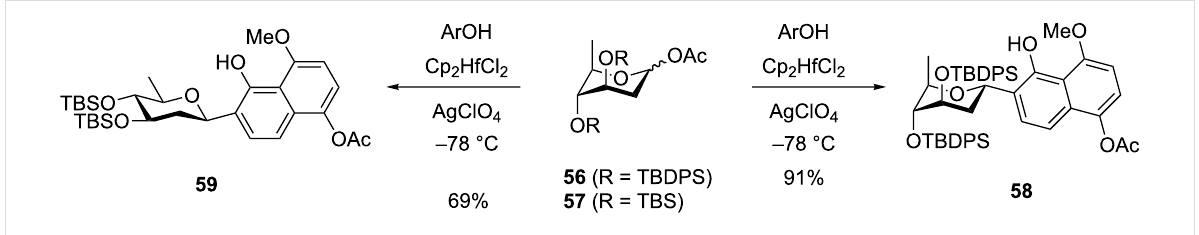
Scheme 10: Superarmed donors used for C -arylation and the dependence of the size of the silylethers on the stereochemical outcome.